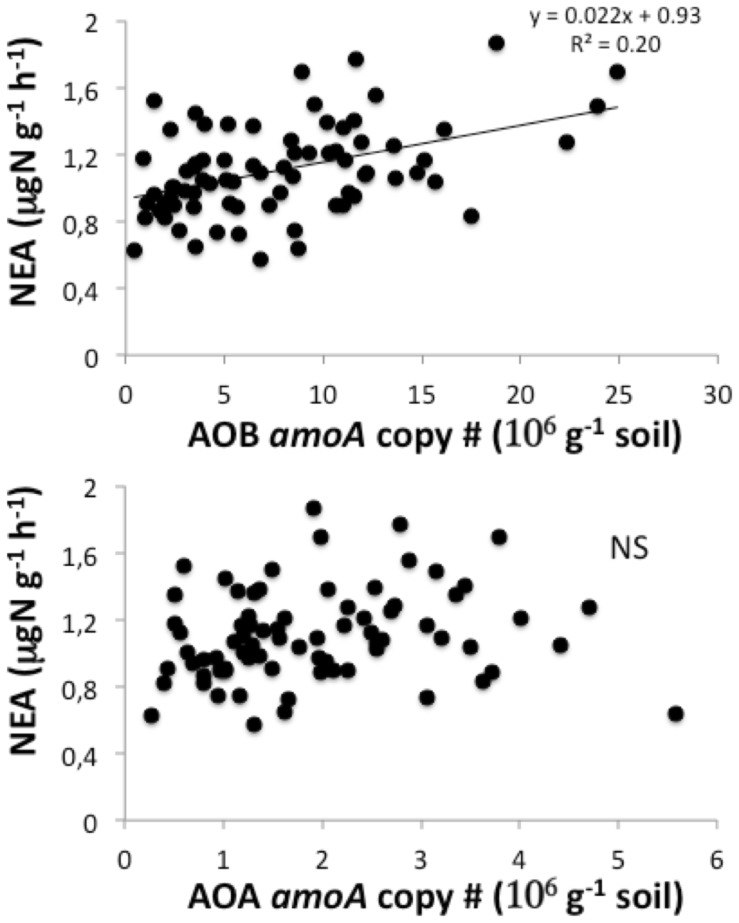
Relationship Between Plant Diversity-induced Changes In Nitrifier Abundance And Nitrifying Enzyme Activity.Correlations between NEA and (top) the abundance of ammonia oxidizing bacteria assessed by the number of their amoA sequences, and (bottom) the abundance of ammonia oxidizing archaea assessed by the number of their amoA sequences, in 2006. When significant (p<0.05), the linear regression is drawn.